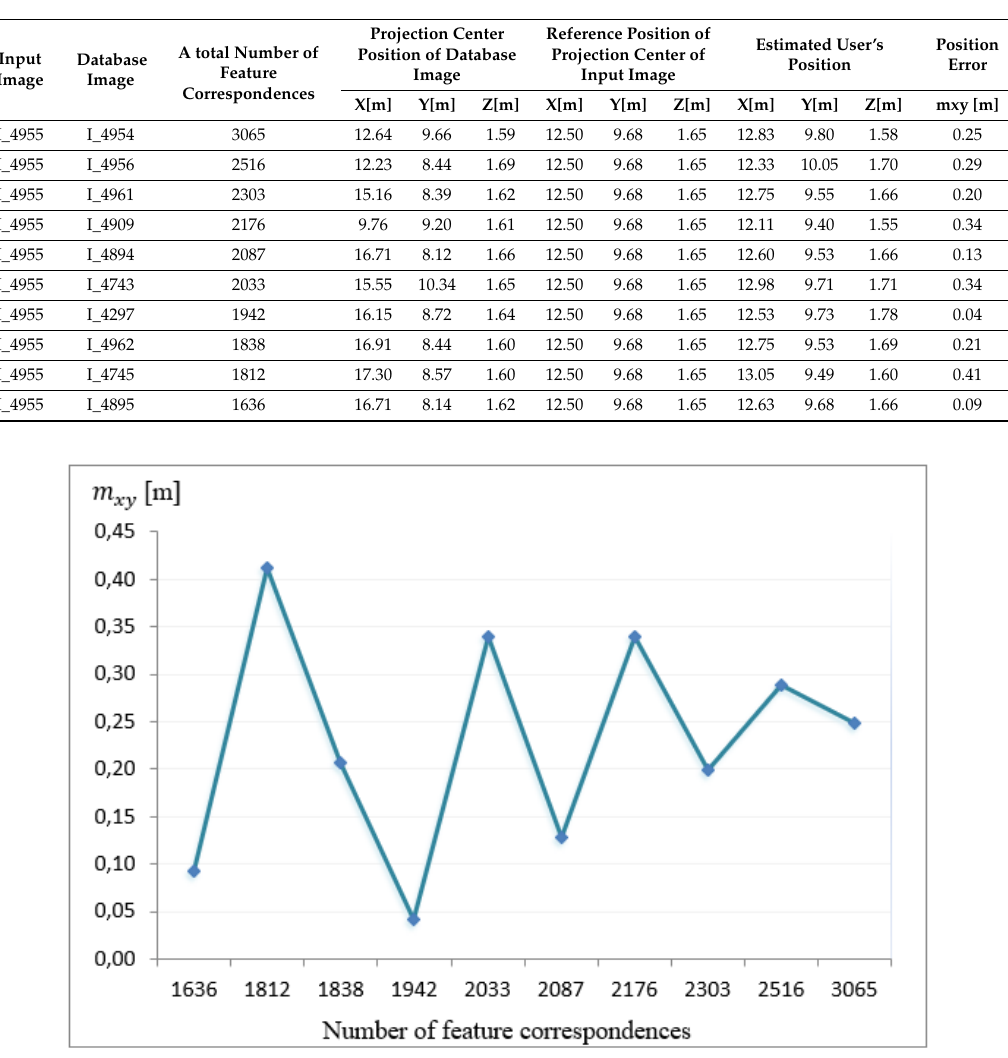
Table 2. Results [39].